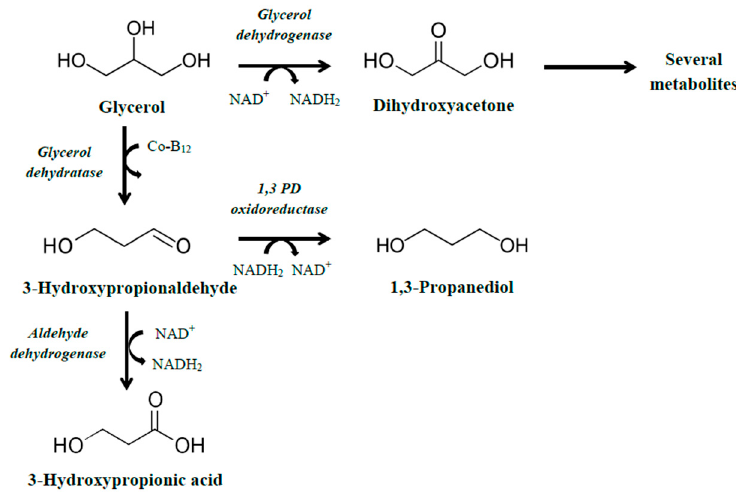
Figure 1. Conversion of glycerol to 3-hydroxypropionic acid (3HP) employing genes from the dha